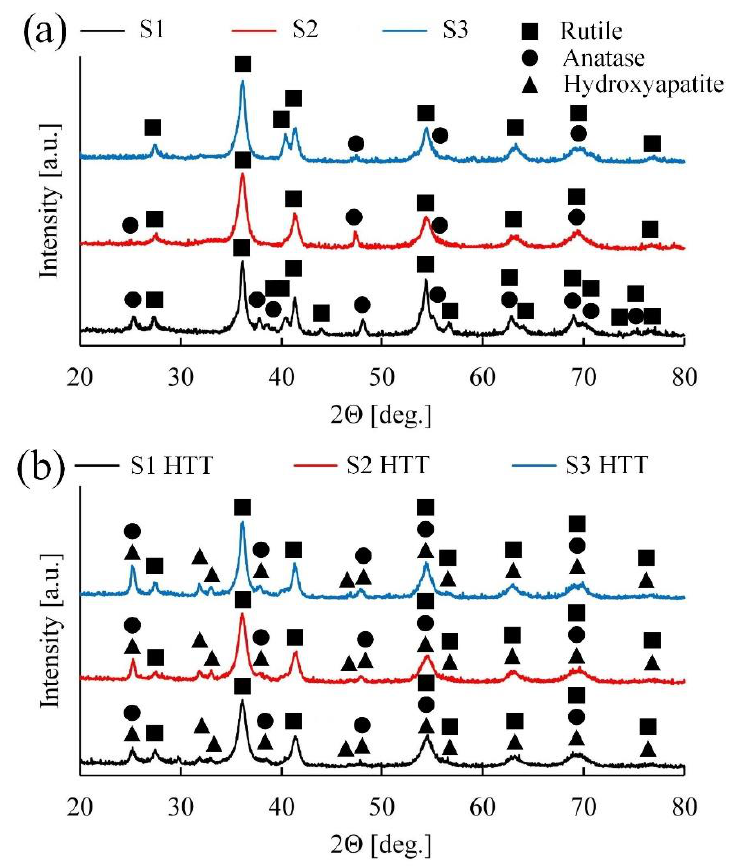
Figure 6. XRD patterns for the coated samples S1 – S3 ( a ) and S1 HTT – S3 HTT ( b